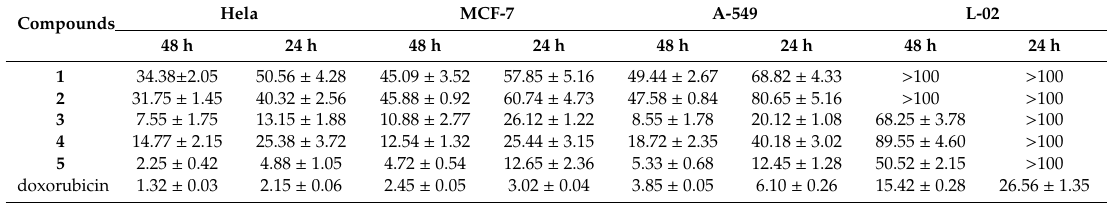
Table 3. Cytotoxicity (IC 50 , µ M ± SD) of compounds 1 – 5 against three human cancer cell lines. Compounds